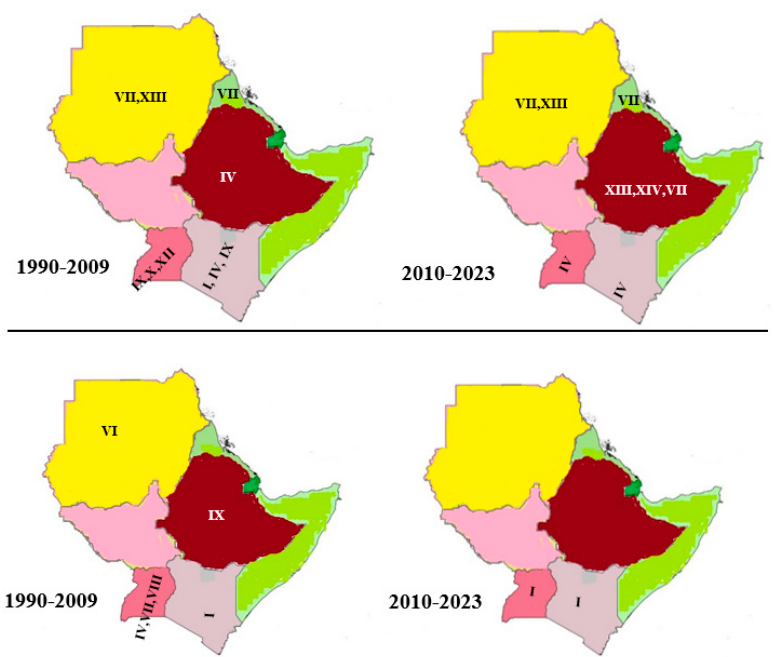
Figure 3. Serotype SAT 2 ( top panel ) and SAT 1 ( bottom panel ) topotype distribution and evolution in the Horn of Africa countries (1990–2023).